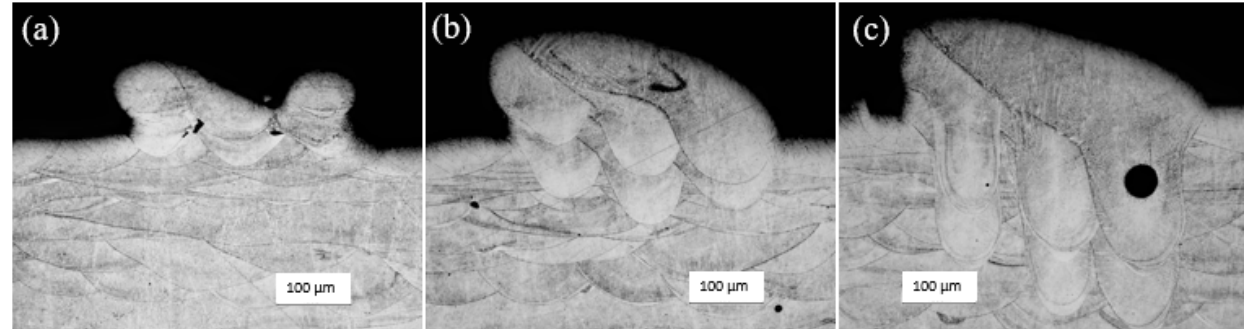
Figure 11. Micrographs of two-layers formed with 195 W laser power, 120 µm hatch spacing, ( a ) 1500 mm/s ( b ) 750 mm/s, and ( c ) 375 mm/s.